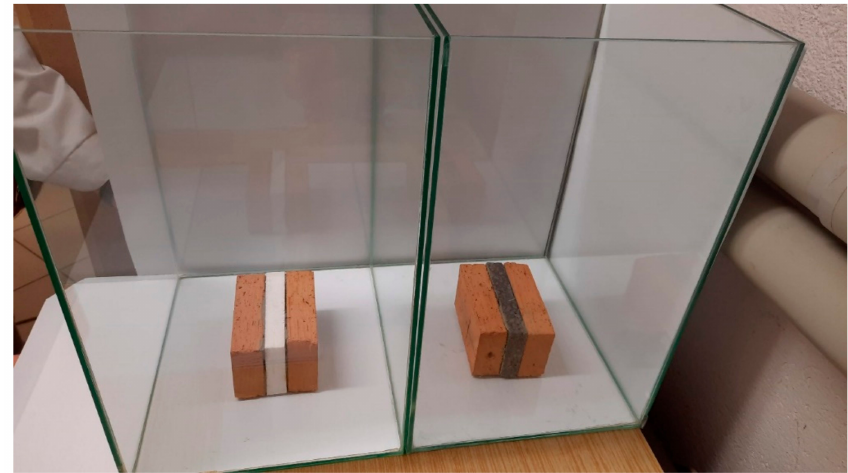
Figure 3. Specimens placed in glass containers.